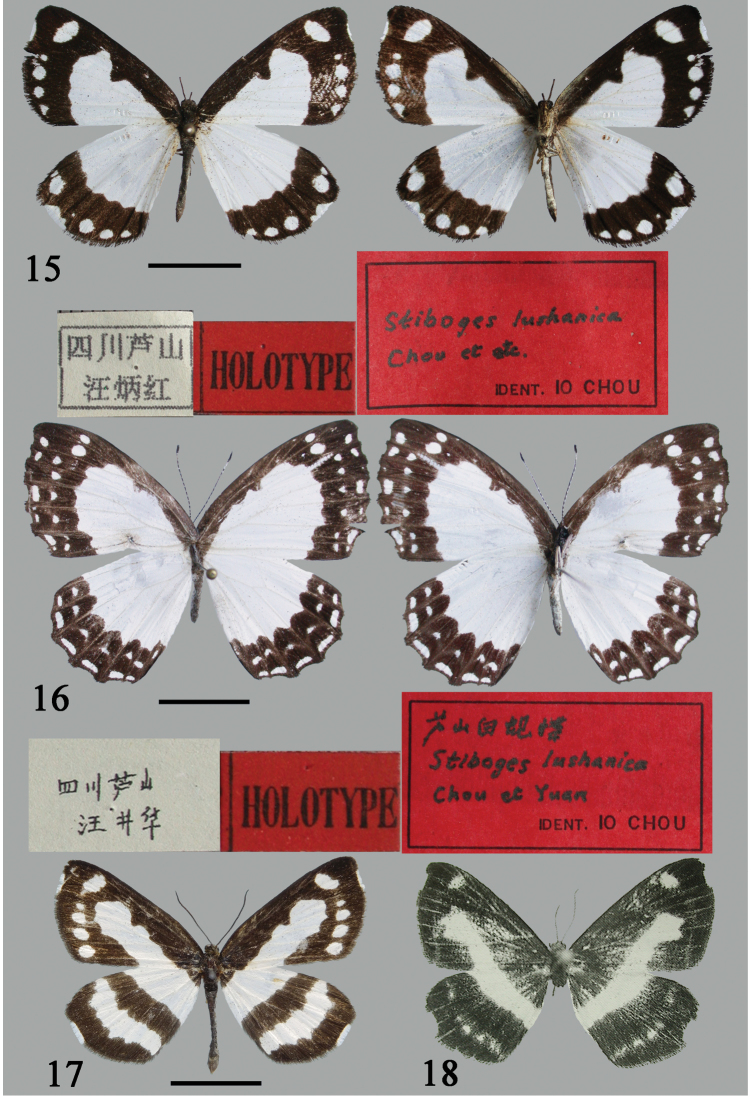
Adults of Psychostrophia spp. and Stiboges sp. 15, 17–18 male 16 female: 15Psychostrophia
nymphidiaria, holotype of Stiboges
lushanica, Lushan, Sichuan 16Stiboges
elodinia, mislabeled specimen of “holotype” of Stiboges
lushanica, Lushan, Sichuan 17Psychostrophia
picaria, Shennongjia, Hubei, PSY017 18 holotype of Psychostrophia
endoi, Xam Neua, Laos, from Inoue (1992). Scale bars: 1 cm.